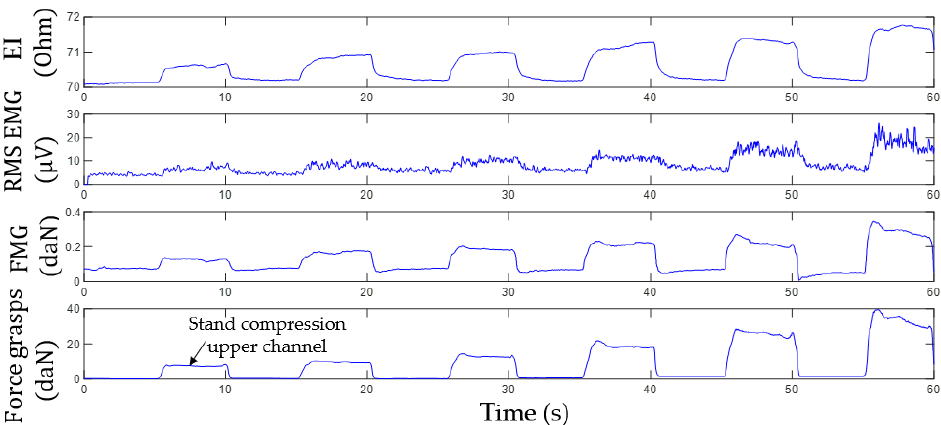
Figure 12. Time histories of EI, EMG, and FMG signals during grasping the isometric stand with variable force. The sensor system is placed at the projection of extensor muscles.